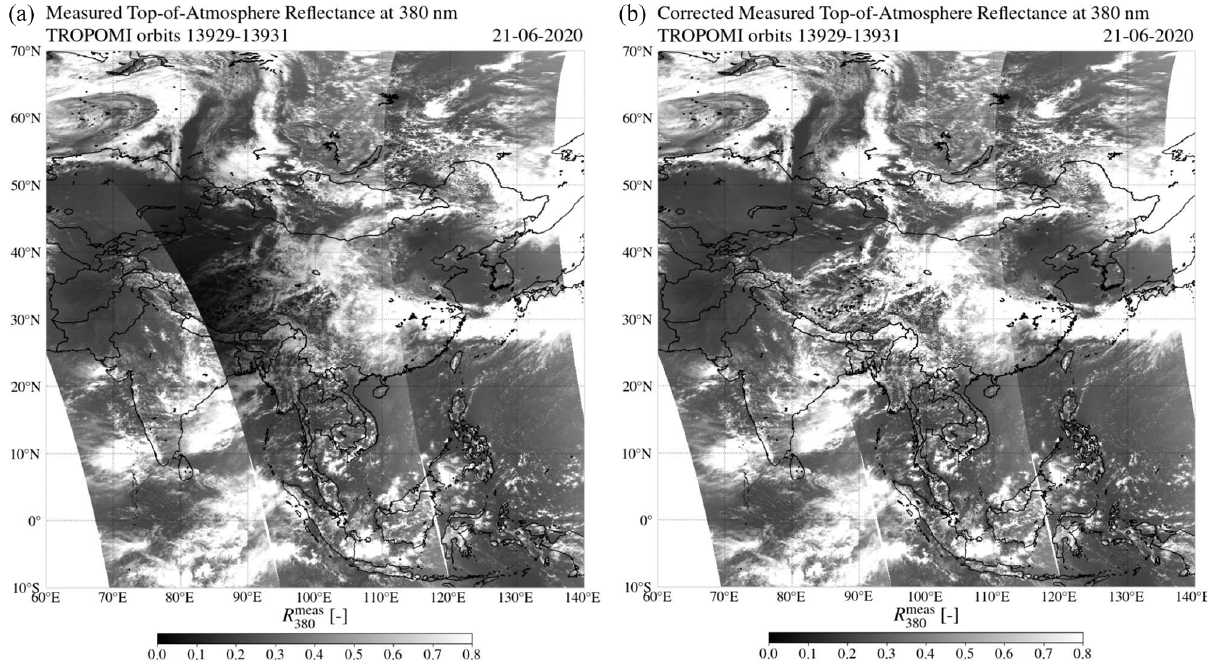
Figure 19. The measured top-of-atmosphere reflectance at 380nm by TROPOMI on 21 June 2020 over Asia in orbits 11403–11405, uncorrected (a) and after the solar irradiance correction (b) .